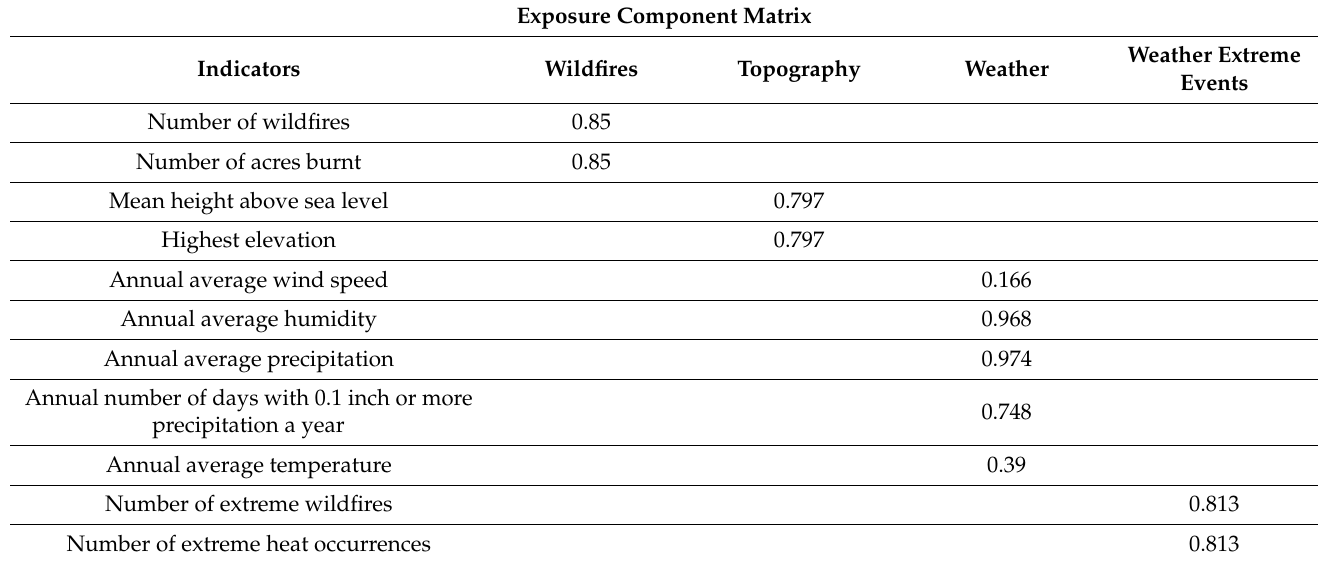
Table A5. A matrix loading table, showing each indicator variable for the exposure contributing factor and its respective loading into each major component (wildfires, topography, weather, and weather extreme